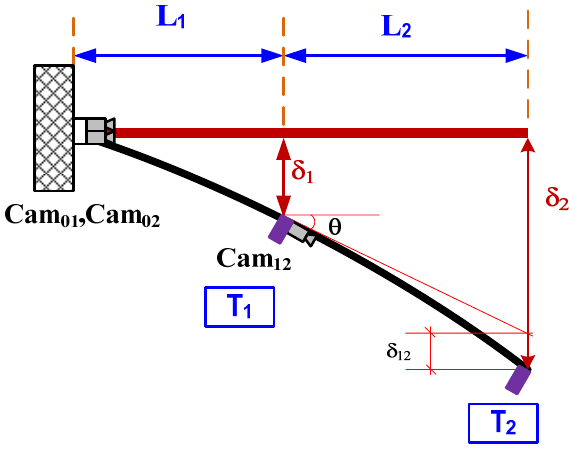
Figure 1. Vision-based dynamic rotation angle